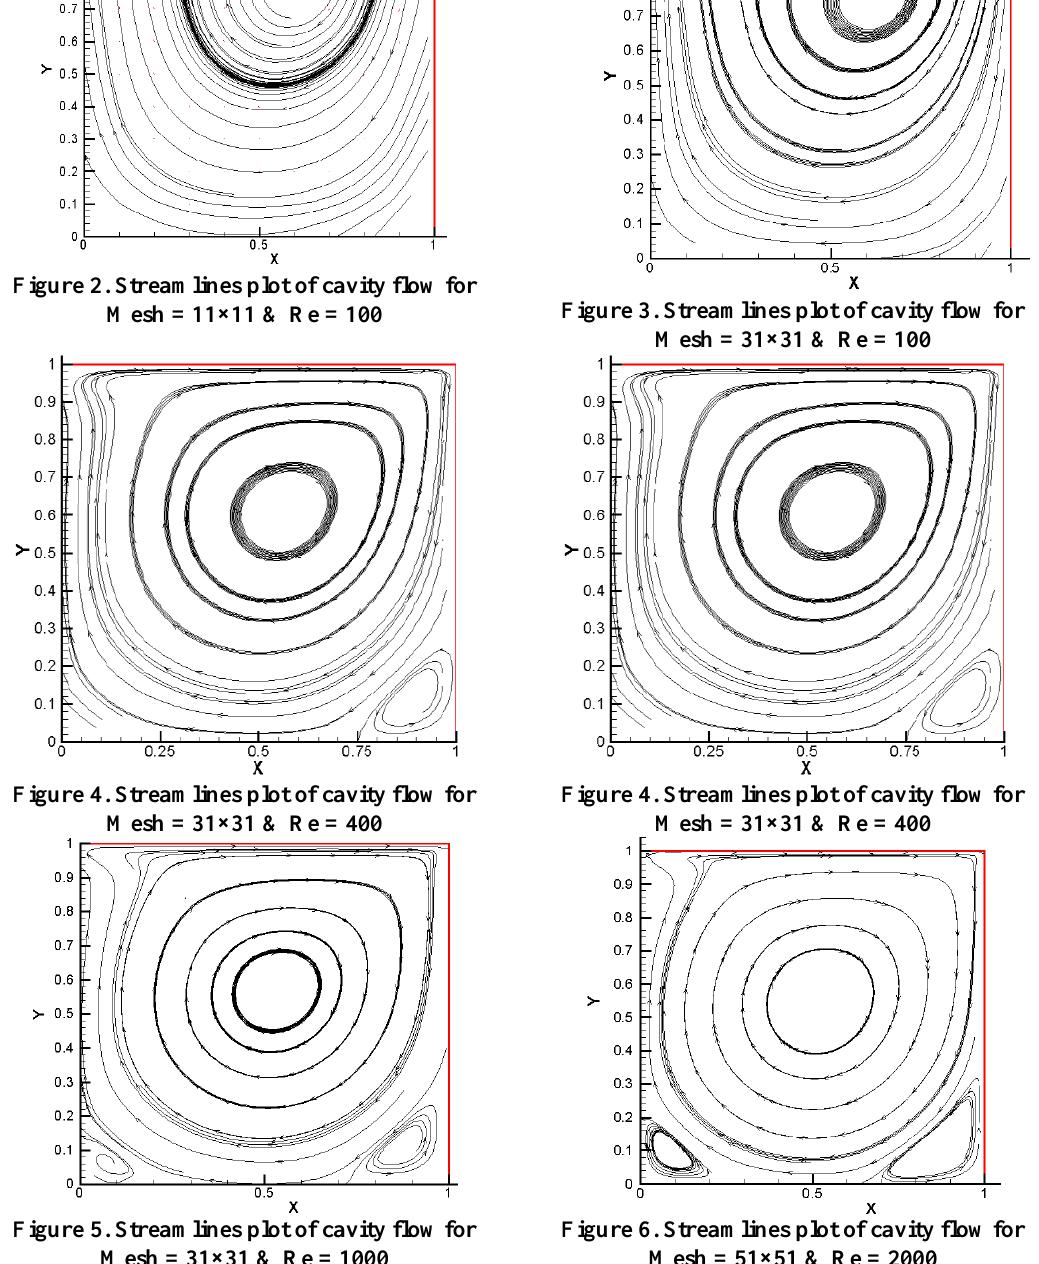
Figure 6. Streamlines plot of cavity flow for Mesh = 51×51 & Re =